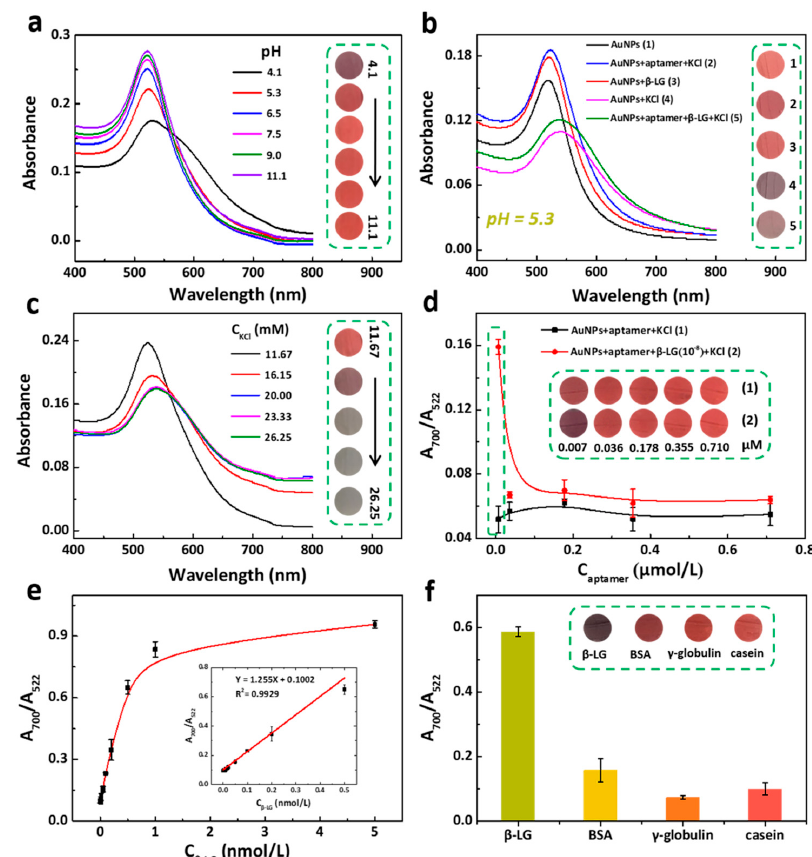
Figure 2. Determination of beta-lactoglobulin ( β -LG) using the uGA assay. ( a ) UV-vis spectra of AuNPs with β -LG at different pH values (4.1, 5.3, 6.5, 7.5, 9.0, and 11.1). Concentrations: AuNPs, 1.86 nM; β -LG, 10 -8 M. ( b ) UV-vis spectra of (1) AuNPs, (2) AuNPs + aptamer + KCl, (3) AuNPs + β -LG, (4) AuNPs